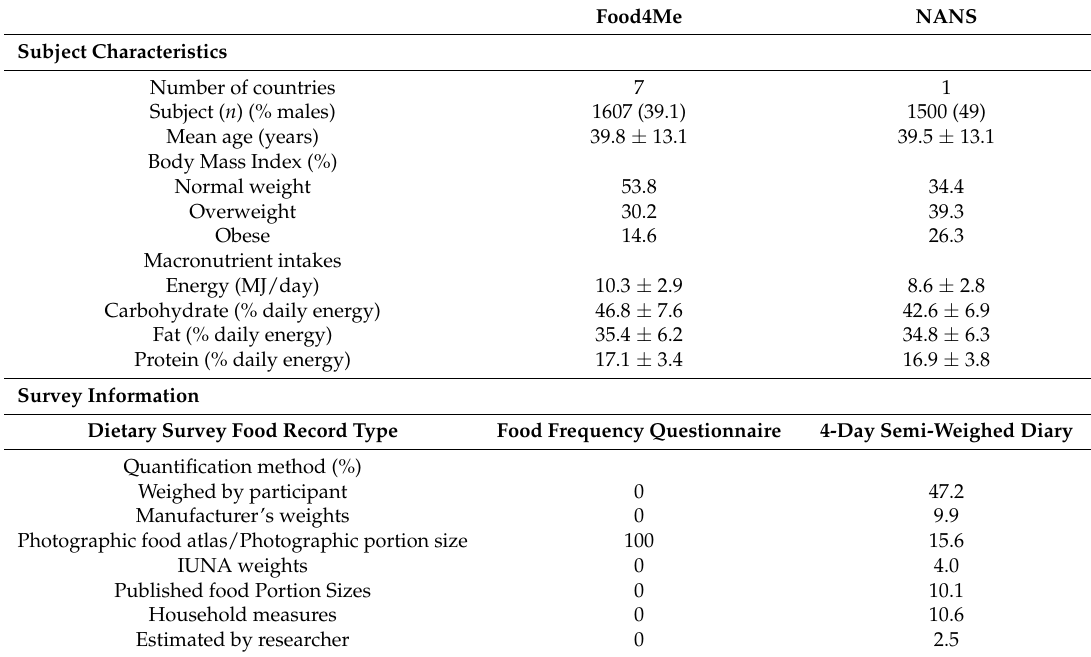
Table 1. Subject and survey characteristics of Food4Me and Irish National Adult Nutrition Survey (NANS) databases. IUNA: Irish Universities Nutrition Alliance. Food4Me